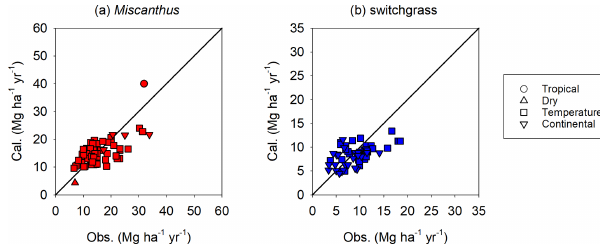
Figure 3. Overall comparison of the calibrated (Cal.) and observed (Obs.) yields for Miscanthus and switchgrass. The black line is the 1 : 1